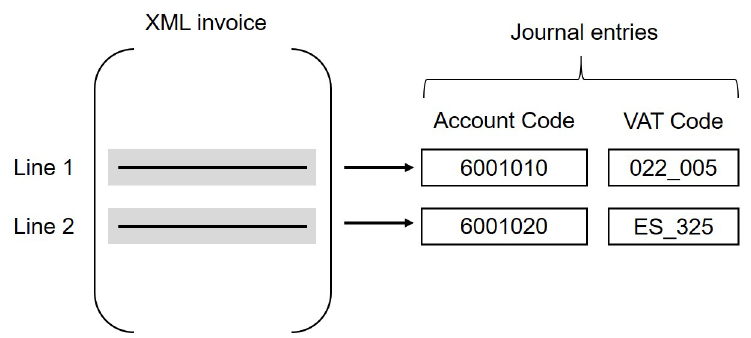
Figure 2. Classification approach to predict VAT codes and account